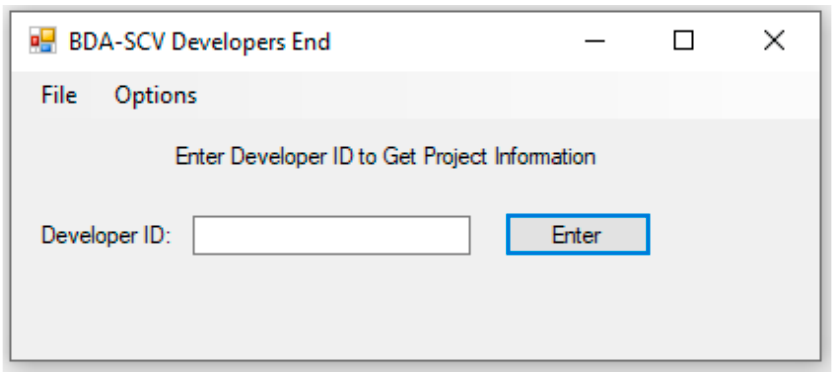
Figure 14. BDA-SCV developer’s end view.